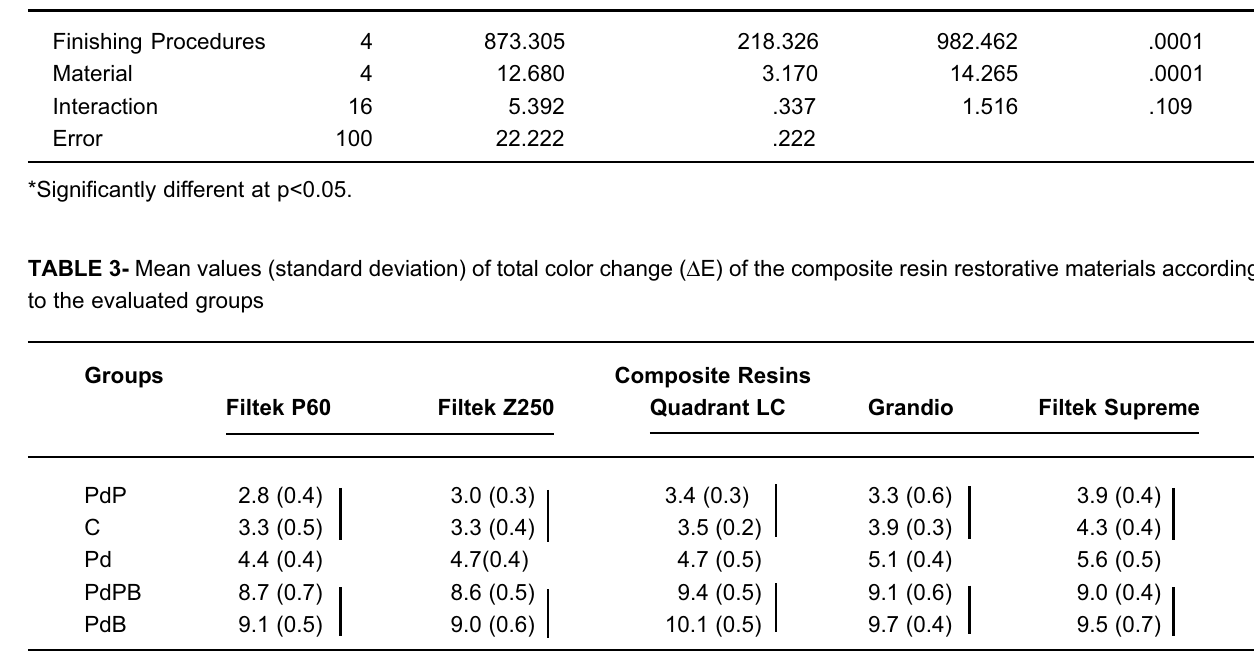
TABLE 2- Two-way analysis of variance for composite resin restorative materials and surface finishing procedures Variable (Source)